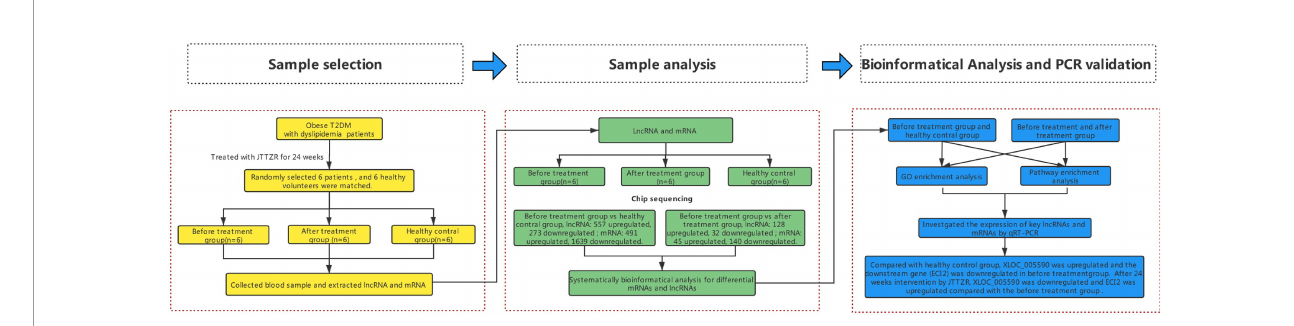
FIGURE 1 | The research processes.